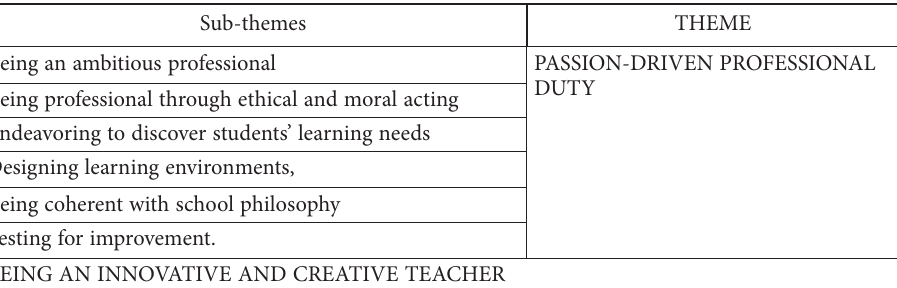
Table 1. Phenomenological structure of being an innovative and creative teacher (source: created by